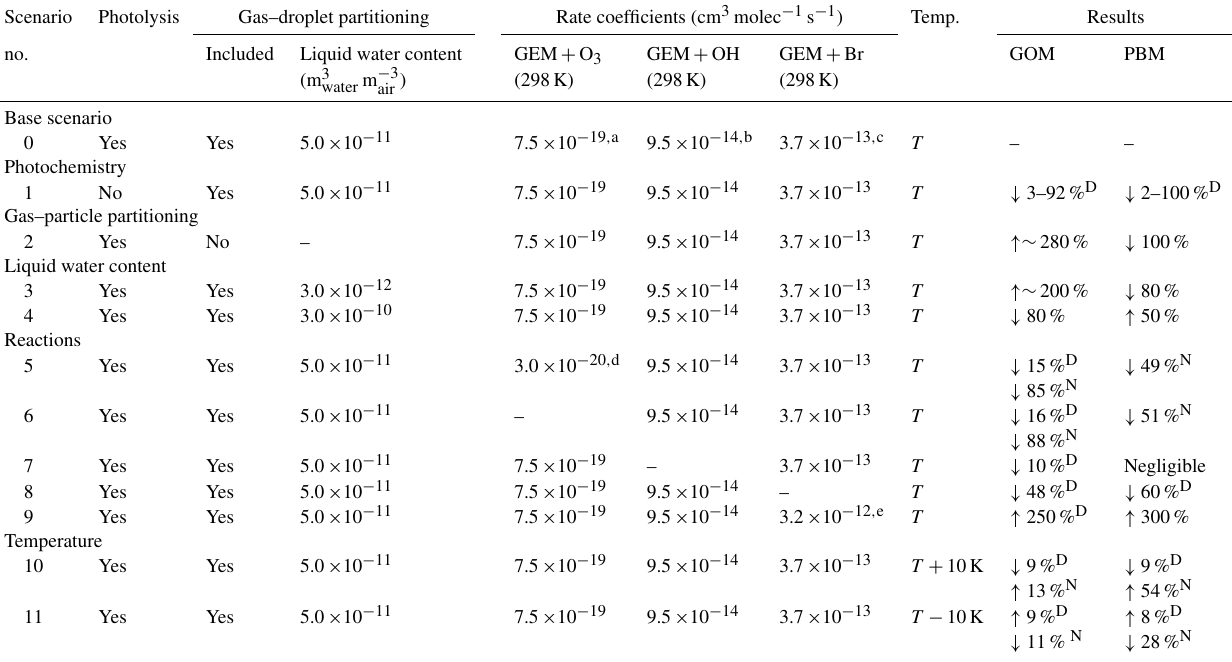
Table 3. Sensitivity scenarios with varying physical and chemical parameters. The superscript D represents daytime and N nighttime. Down- ward arrows stand for decreases and upward arrows for increases. T stands for the temperature diurnal cycle in the base scenario, and T + 10K or T − 10K represents a 10K higher temperature or a 10K lower temperature throughout the day,